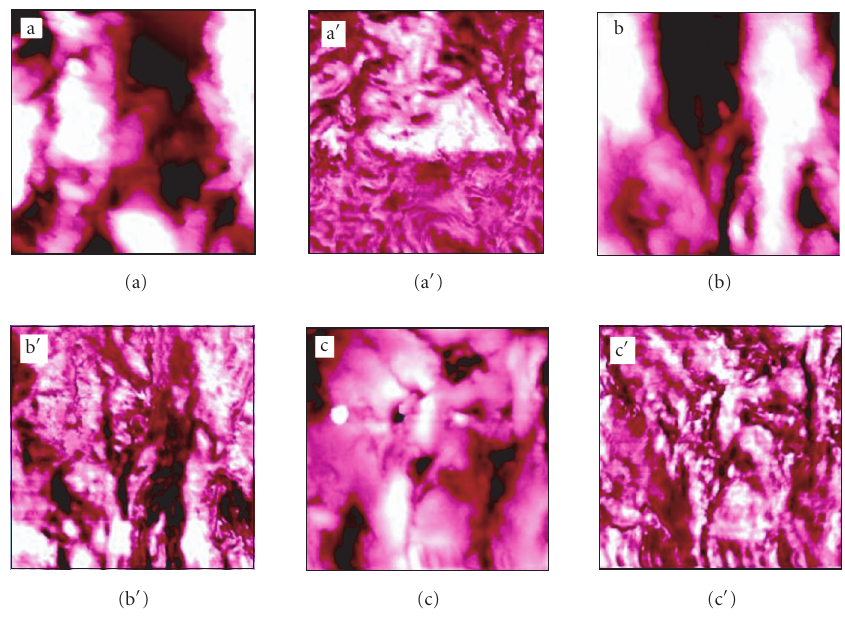
Figure 29: Shear-force AFM topographies (20 μ m, Z range 1 μ m) at three di ff erent sites (a), (b), (c) and the corresponding optical contrast (a (cid:3) ), (b (cid:3) ), (c (cid:3) ) of apertureless SNOM on the rough surfaces of cancerous bladder tissue showing plate-like bright contrast